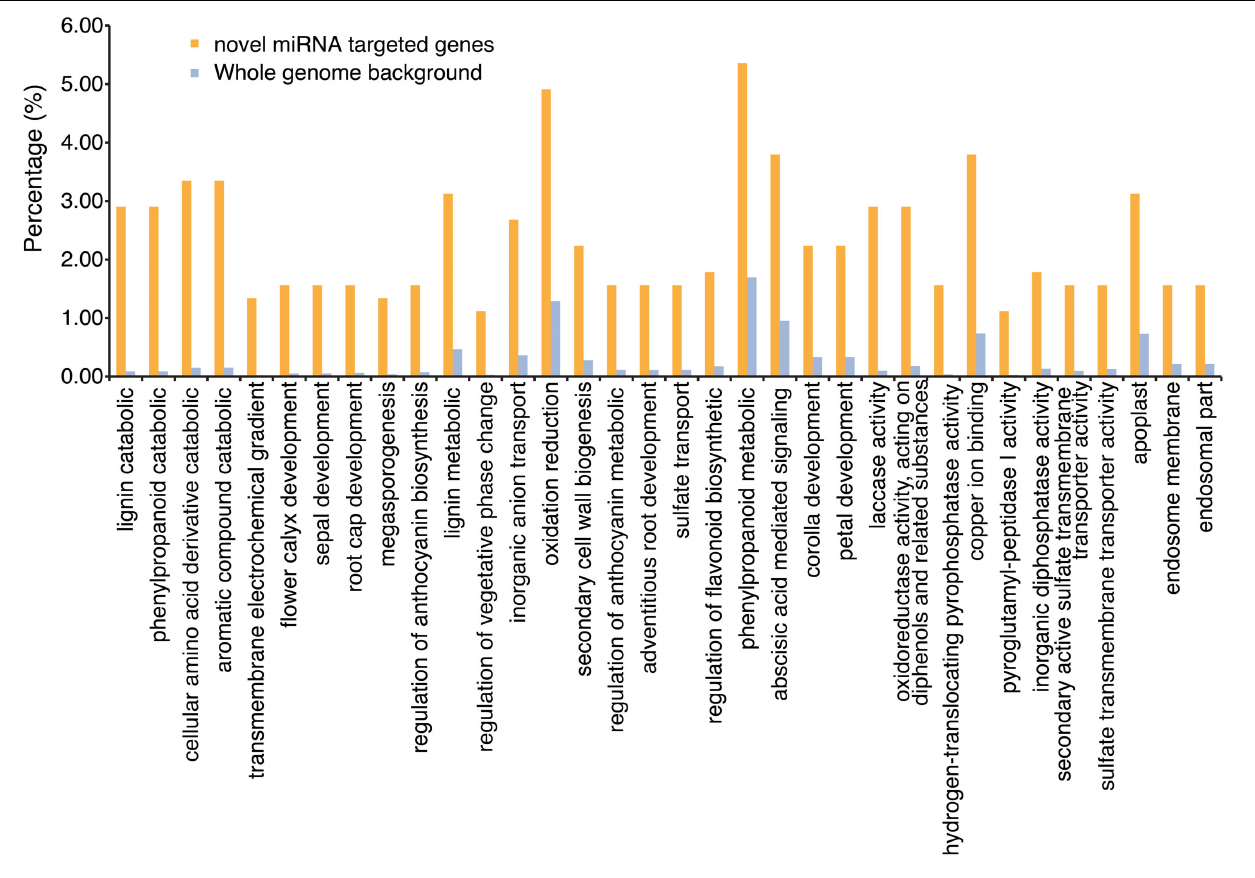
FIGURE 4 | Over-represented Gene Ontology terms associated with predicted mRNA targets of the putative novel miRNAs found in this study. Gene Ontology (GO) terms associated with these gene models were processed to identify over-represented GO terms, using AgriGO (bioinfo.cau.edu.cn/agriGO). The graph indicates the percentage of